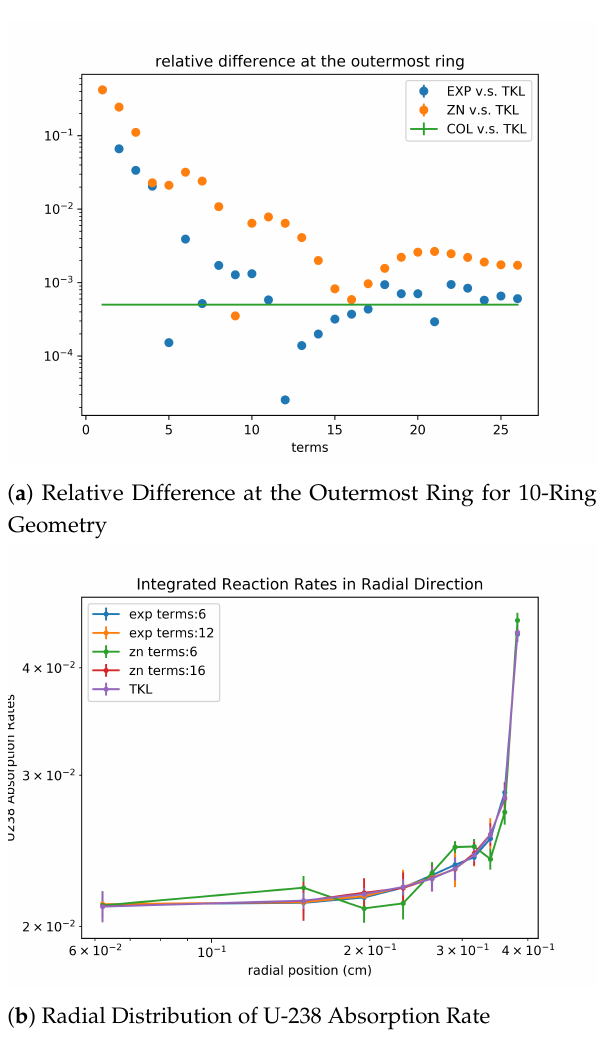
Figure 2. Comparison between Exponential and Zerinke-based